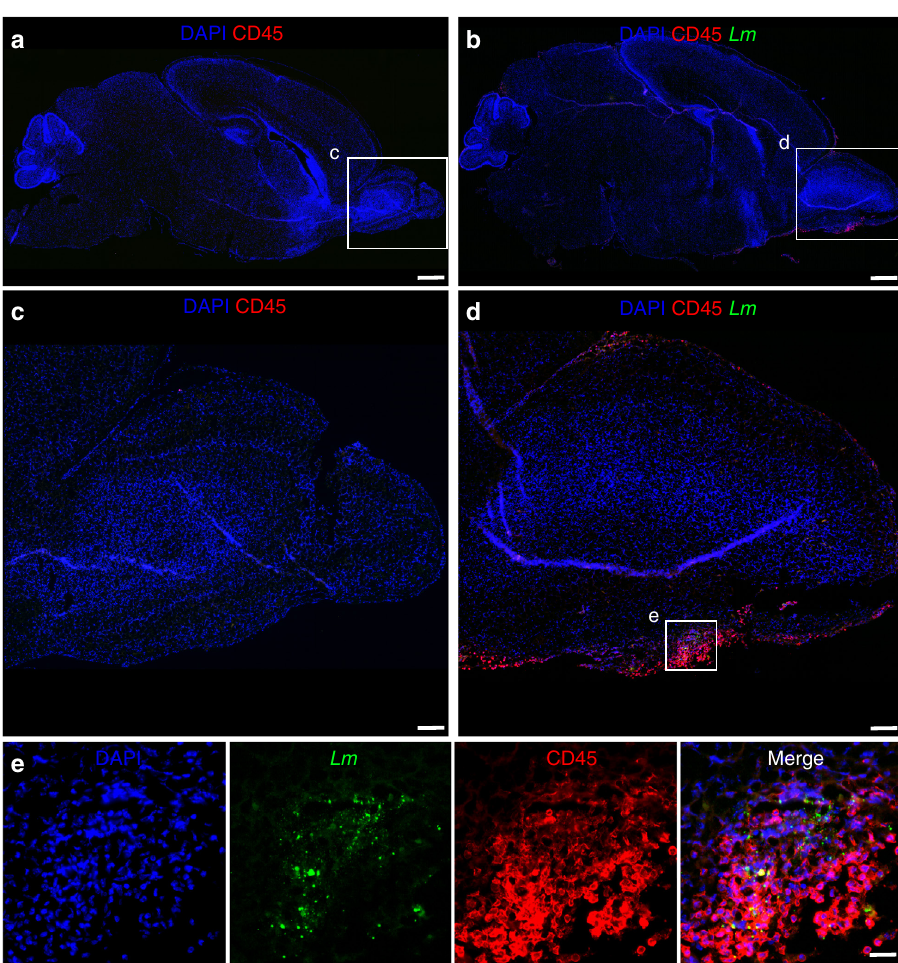
Fig. 6 Accumulation of immune cells in the CNS. One-day-old mice were either infected i.n. with 1 × 10 5 CFU Lm b , d , e or exposed to sterile PBS a , c . Tissue sections were stained for Lm (green), the leukocyte marker CD45 (red), and DNA (DAPI, blue). Sagittal overview of entire brain tissue of an age- matched control mouse ( a ) and after i.n. infection at 3 dpi ( b ) (scale bar 500 µ m). Respective zoomed view of the olfactory bulb ( c ) and ( d ) (scale bar 100 µ m). e Zoomed view from d (scale bar 20 µ m). DAPI (blue), Lm (green), and CD45 (red) are shown separately ( fi rst three panels) and as a merge image. Images are representative for samples from n = 6 pups; images of age-matched controls are derived from n = 6